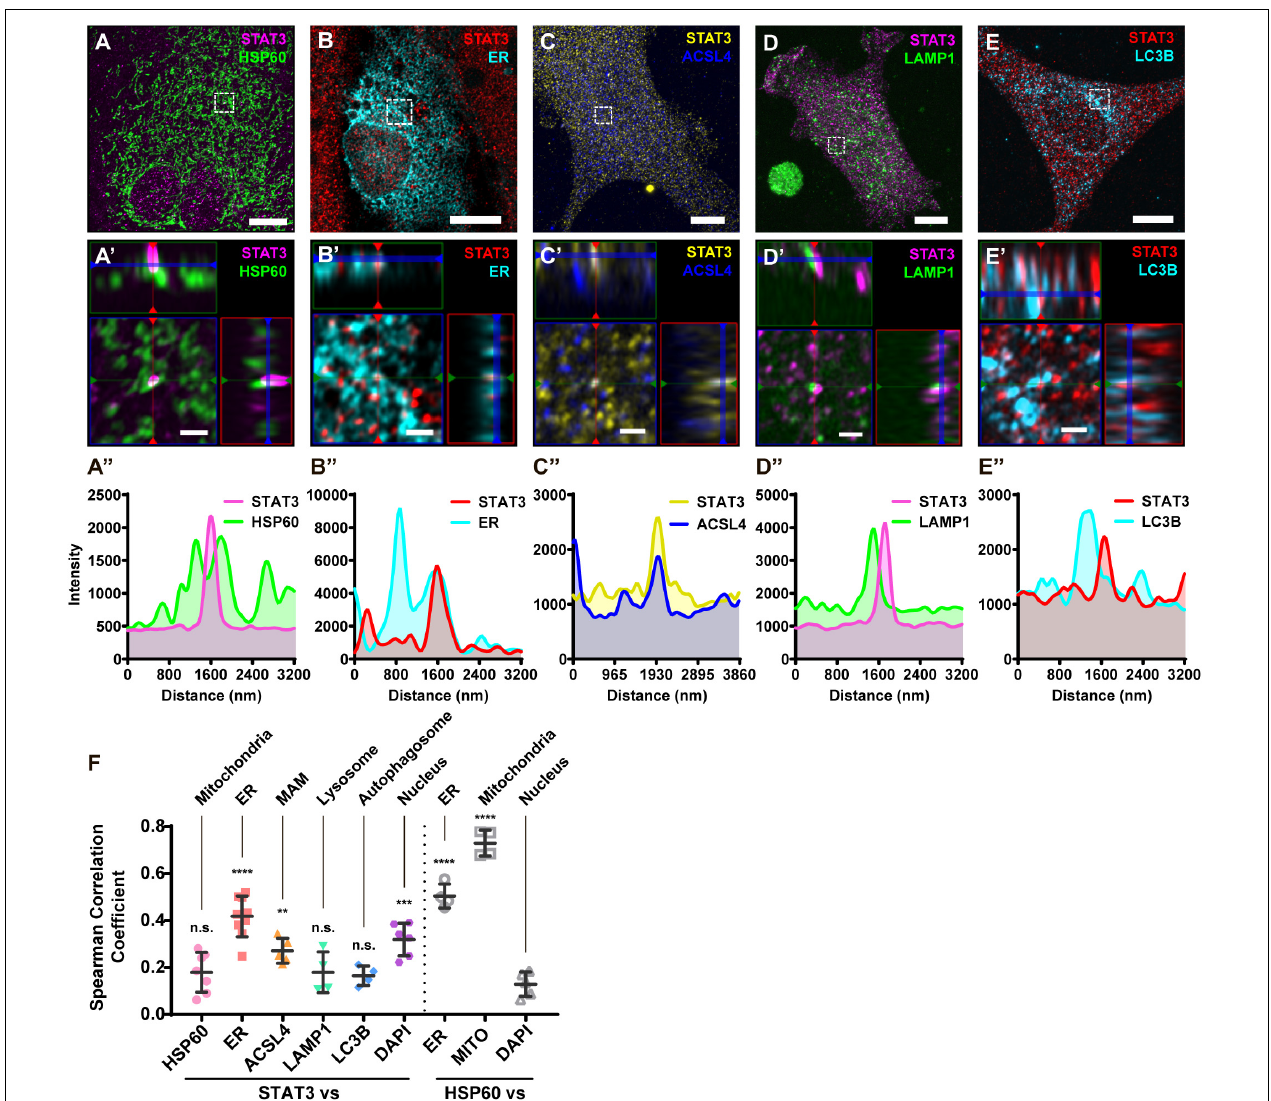
FIGURE 2 | Immunofluorescence of primary astrocytes demonstrate that STAT3 does not colocalize with mitochondria. (A) Representative sub-diffraction maximum-intensity-projection image of immunofluorescence labeling of STAT3 and HSP60 in primary astrocytes (Scale bar: 10 um). (A (cid:48) ) The orthogonal views of the highlighted areas (Scale bar: 1 um). (A (cid:48)(cid:48) ) Profiling of STAT3 and HSP60 signal intensity along green line in (A (cid:48) ) . (B) Representative image of STAT3 and ER-dsRed (ER) co-labeling (Scale bar: 10 um). (B (cid:48) ) The orthogonal views of the highlighted areas (Scale bar: 1 um). (B (cid:48)(cid:48) ) Profiling of STAT3 and ER signal intensity along green line in (B (cid:48) ) . (C) Representative image of STAT3 and ACSL4 co-staining (Scale bar: 10 um). (C (cid:48) ) The orthogonal views of the highlighted areas (Scale bar: 1 um). (C (cid:48)(cid:48) ) Profiling of STAT3 and ACSL4 signal intensity along green line in (C (cid:48) ) . (D) Representative image of STAT3 and LAMP1 co-staining (Scale bar: 10 um). (D (cid:48) ) The orthogonal views of the highlighted areas (Scale bar: 1 um). (D (cid:48)(cid:48) ) Profiling of STAT3 and LAMP1 signal intensity along green line in (D (cid:48) ) . (E) Representative image of STAT3 and LC3B co-staining (Scale bar: 10 um). (E (cid:48) ) The orthogonal views of the highlighted areas (Scale bar: 1 um). (E (cid:48)(cid:48) ) Profiling of STAT3 and LC3B signal intensity along green line in (E (cid:48) ) . (F) Spearman correlation coefficients calculated by Coloc2 ( N = 2, n ≥ 2). Statistic test was conducted to evaluate the difference between each group and the negative control (HSP60 vs. DAPI) **** p < 0.0001, *** p < 0.001, ** p < 0.005, n.s., not significant; MITO, Mitotracker